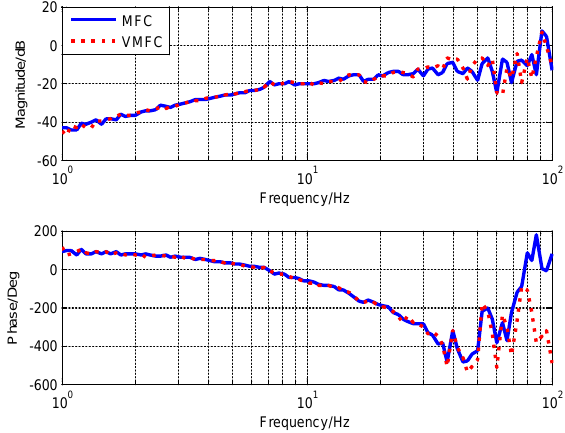
Figure 10. The comparison of tracking characteristics between the MFC and virtual multi-loop feedback control (VMFC).